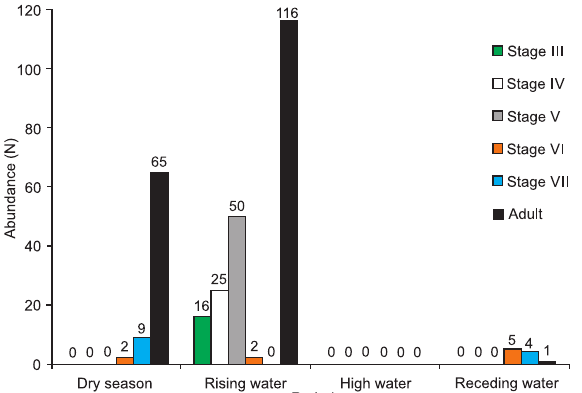
Figure 4. Distribution of Promestosoma boggianii according to stages of development (juvenile stages III, IV, V, VI, VII and adult) throughout the seasonal periods (dry season, rising water, high water and receding water) in a floodplain of Mato Grosso’s northern Pantanal region,